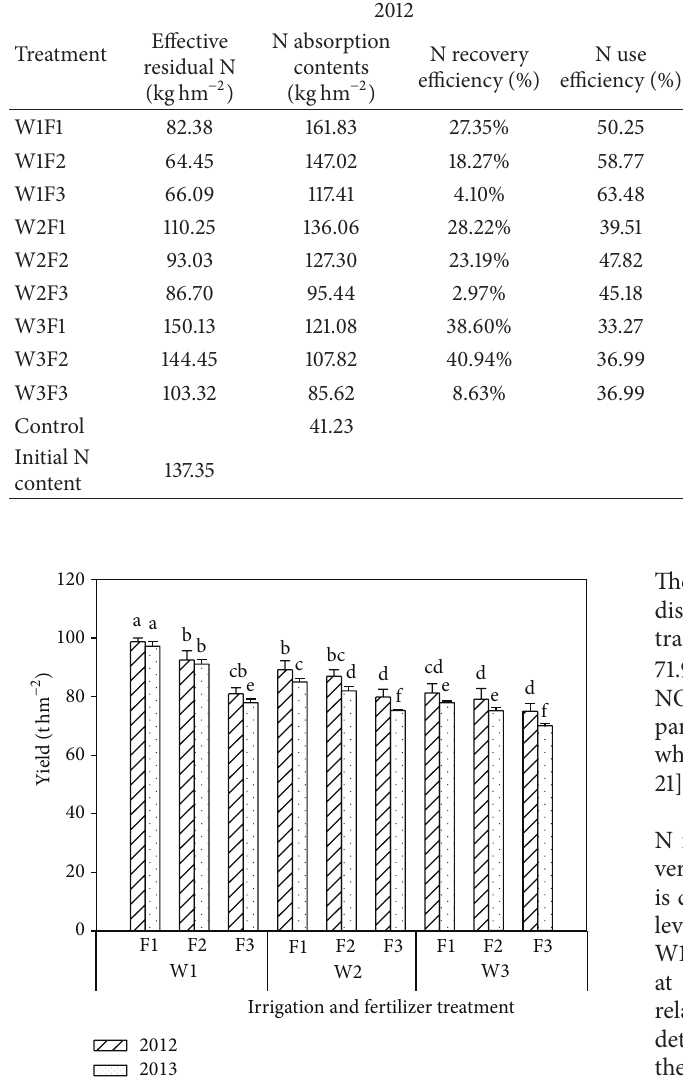
Figure 7: Effects of different irrigation and fertilizer treatments on tomato yield in the 2012 and 2013 seasons. Columns with the same letter represent values that are significant at the 5% probability level. Each value is the mean ± SD ( 𝑛 = 3